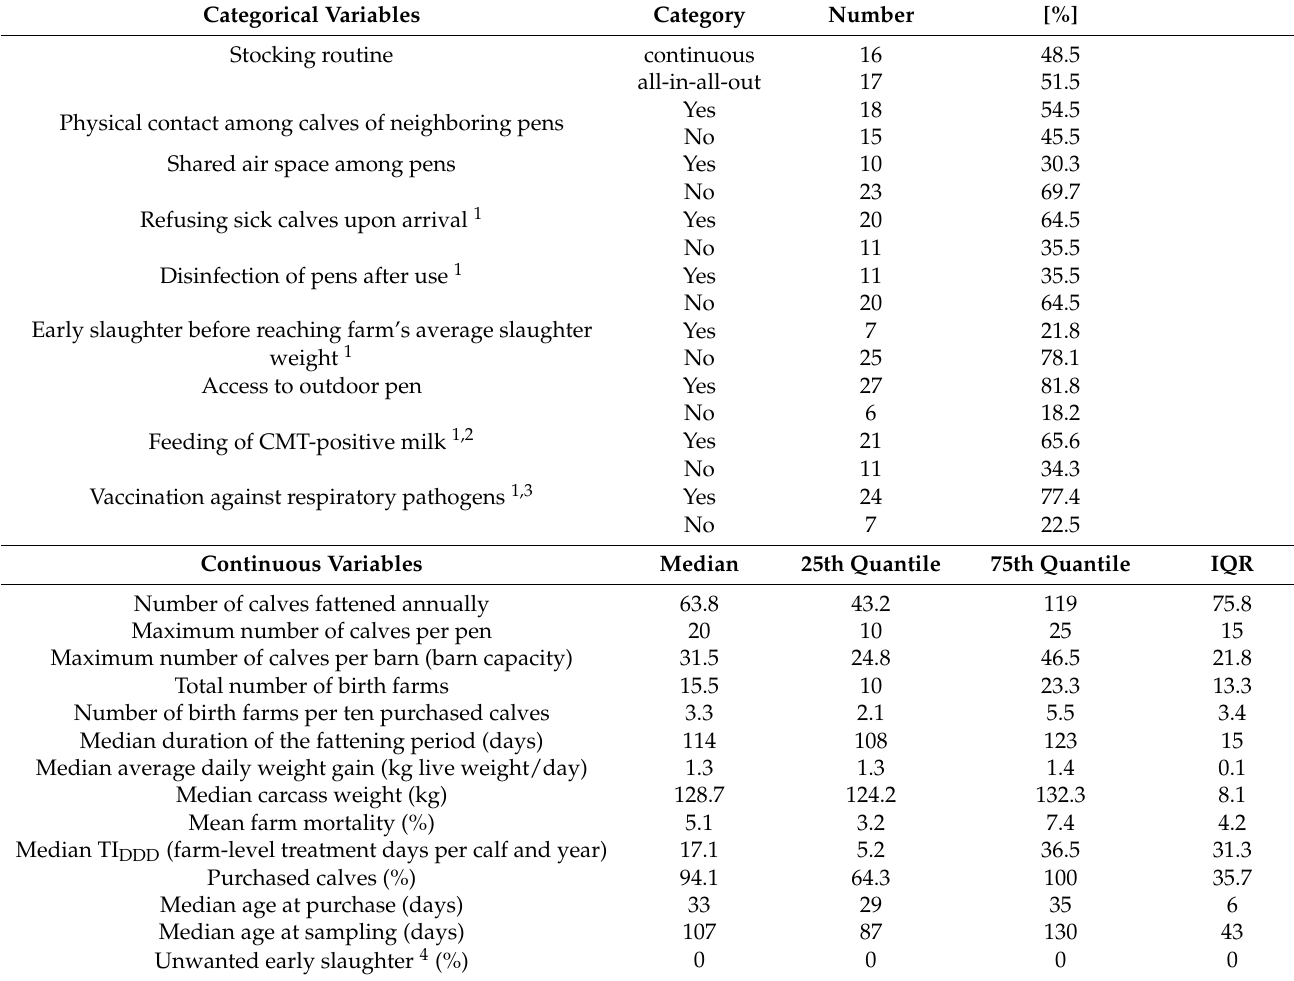
Table 1. Farm characteristics of 33 veal fattening farms in Switzerland. The categories with the corresponding numbers of farms and percentages are indicated for categorical variables. The median, quantiles (25th, 75th), and interquartile range (IQR) values at the farm-level are indicated for continuous